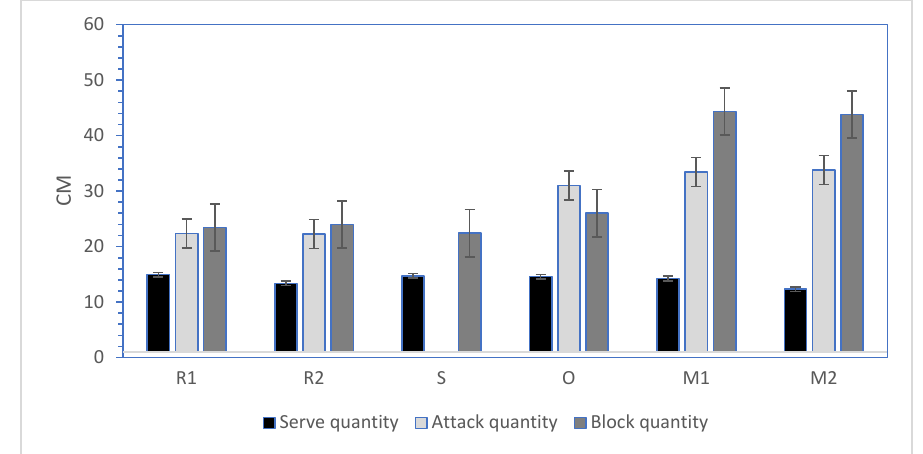
Figure 5. The number of jumps serves did not differentiate among the players regarding their position on the court (R1, R2—Receiver; S—Setter; O—Opposite; M1, M2—Middle blocker).